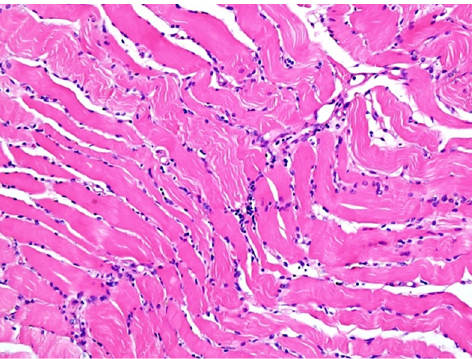
Figure 3. Haematoxylin-eosin coloration. Microscopic features of skeletal muscle inflammation; interstitial aggregates of lymphocytes and macrophages can be noticed; HE, ×200.